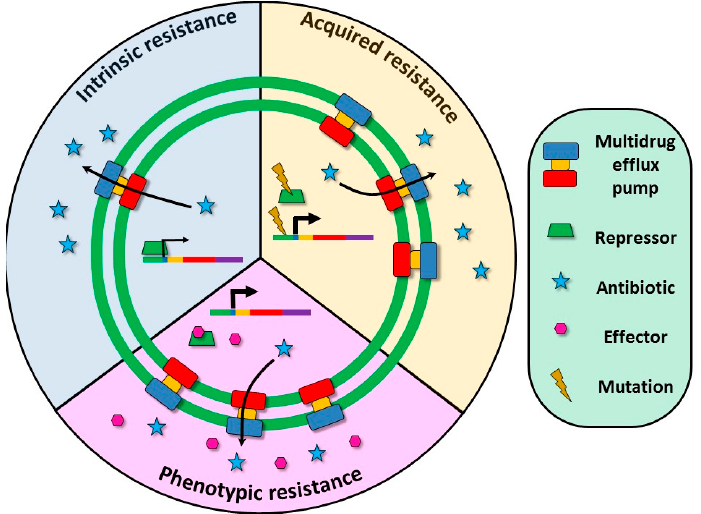
Figure 2. Role of multidrug efflux pumps in antibiotic resistance. Expression of efflux pumps is frequently down-regulated by transcriptional repressors encoded upstream of the pump operon. Consequently, MDR efflux pumps can contribute to the phenotype of antibiotic resistance at different levels, depending on their expression level. Intrinsic resistance: Some MDR efflux pumps, such as P. aeruginosa MexAB-OprN [62] or E. coli AcrAB-TolC [63], present a basal level of expression, enough for contributing to the intrinsic antimicrobial resistance of these microorganisms (blue in the Figure). Acquired resistance: De-repression of the expression of the efflux pumps can be achieved by mutations at the regulatory proteins, rendering stable acquired resistance (yellow in the Figure). Phenotypic resistance: The expression of efflux pumps can by triggered in the presence of specific inducers, rendering transient phenotypic resistance (pink in the Figure).